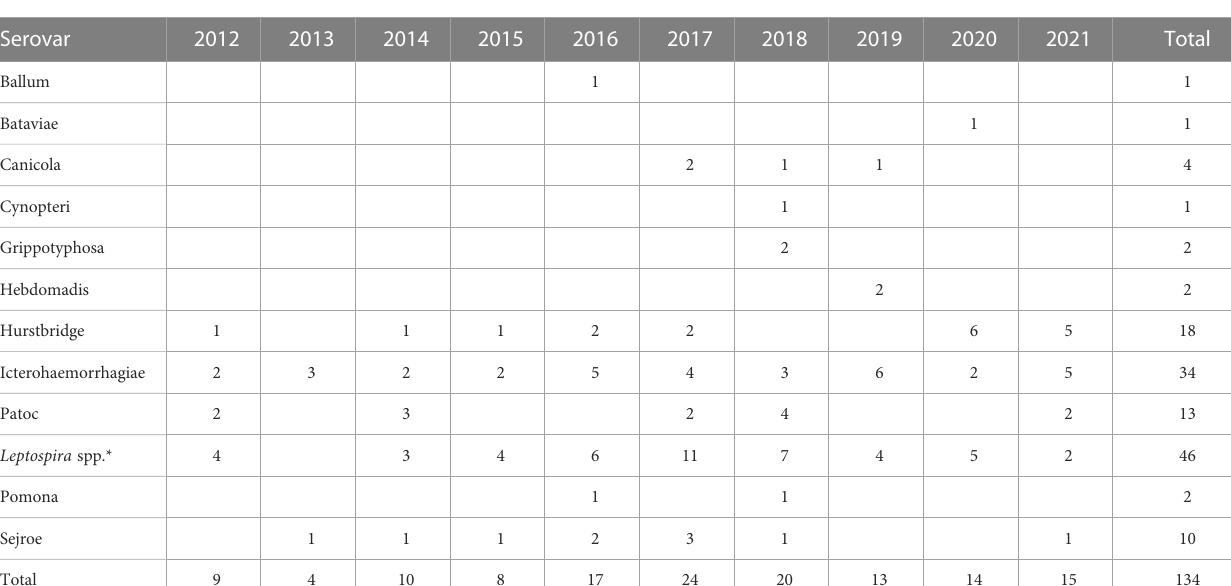
TABLE 1 Reported cases leptospirosis by serovar and year, Denmark, 2012-2021.